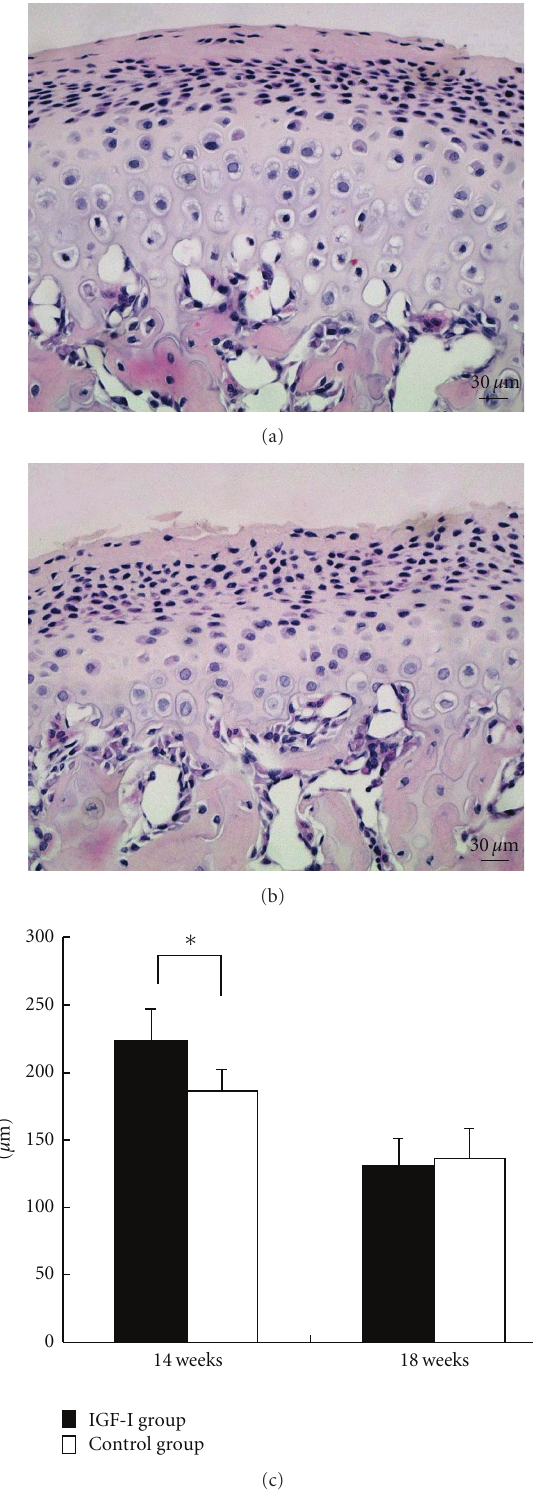
Figure 7: (a, b) Coronal sections of the cartilaginous layer in the mandibular condyle in the IGF-I group (a) and the control group (b) at 14 weeks of age (hematoxylin-eosin staining, 200x magnification, bars = 30 μ m). (c) Width of the cartilaginous layer. Data represent the mean ± SD of six rats ( ∗ P < 0 . 05 versus control); adapted from a previous report